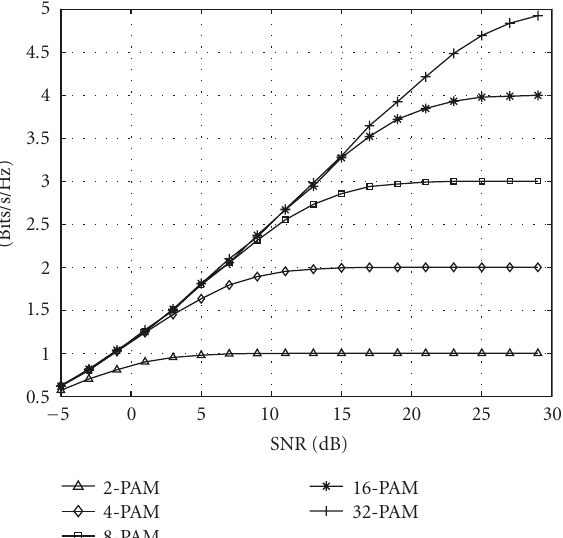
Figure 6: Capacity of a UWB system with PAM over a multipath fading channel with L = 4 and m = 0 . 65.